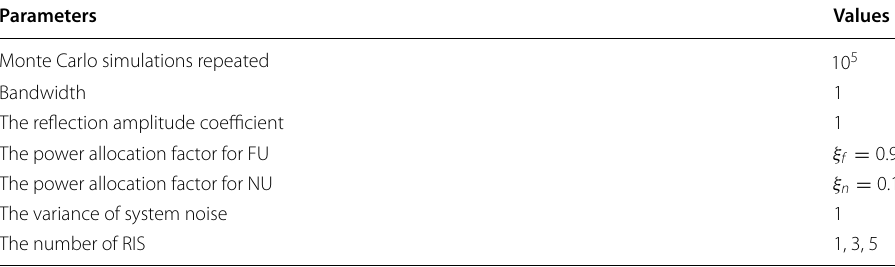
Table 1 Parameters for numerical results Parameters Values Monte Carlo simulations repeated 10 5 Bandwidth 1 The reflection amplitude coefficient 1 The power allocation factor for FU ξ f = 0.9 The power allocation factor for NU ξ n = 0.1 The variance of system noise 1 The number of RIS 1, 3,